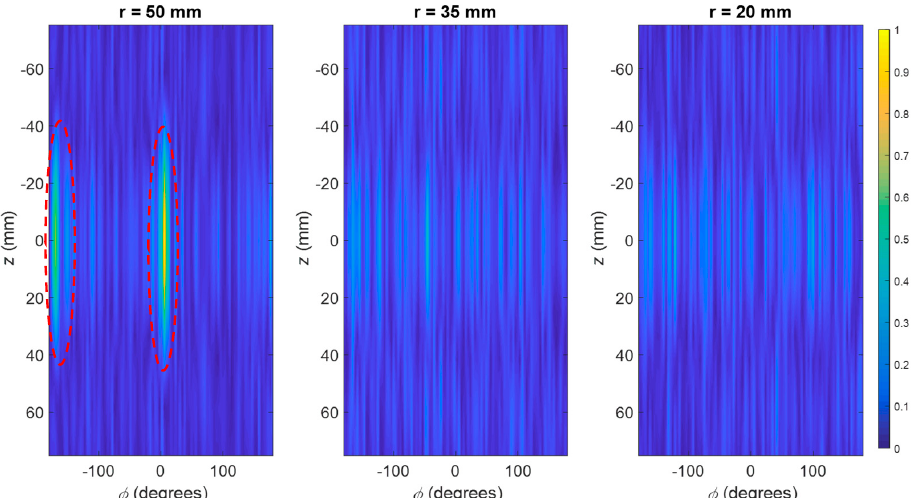
Figure 17. Normalized 3D reconstructed image of the objects on the outer surface for three imaged surfaces at radii of 50, 35, and 20 mm using double frequency data collected by eight receiver antennas. The red dashed lines show the reconstructed objects.